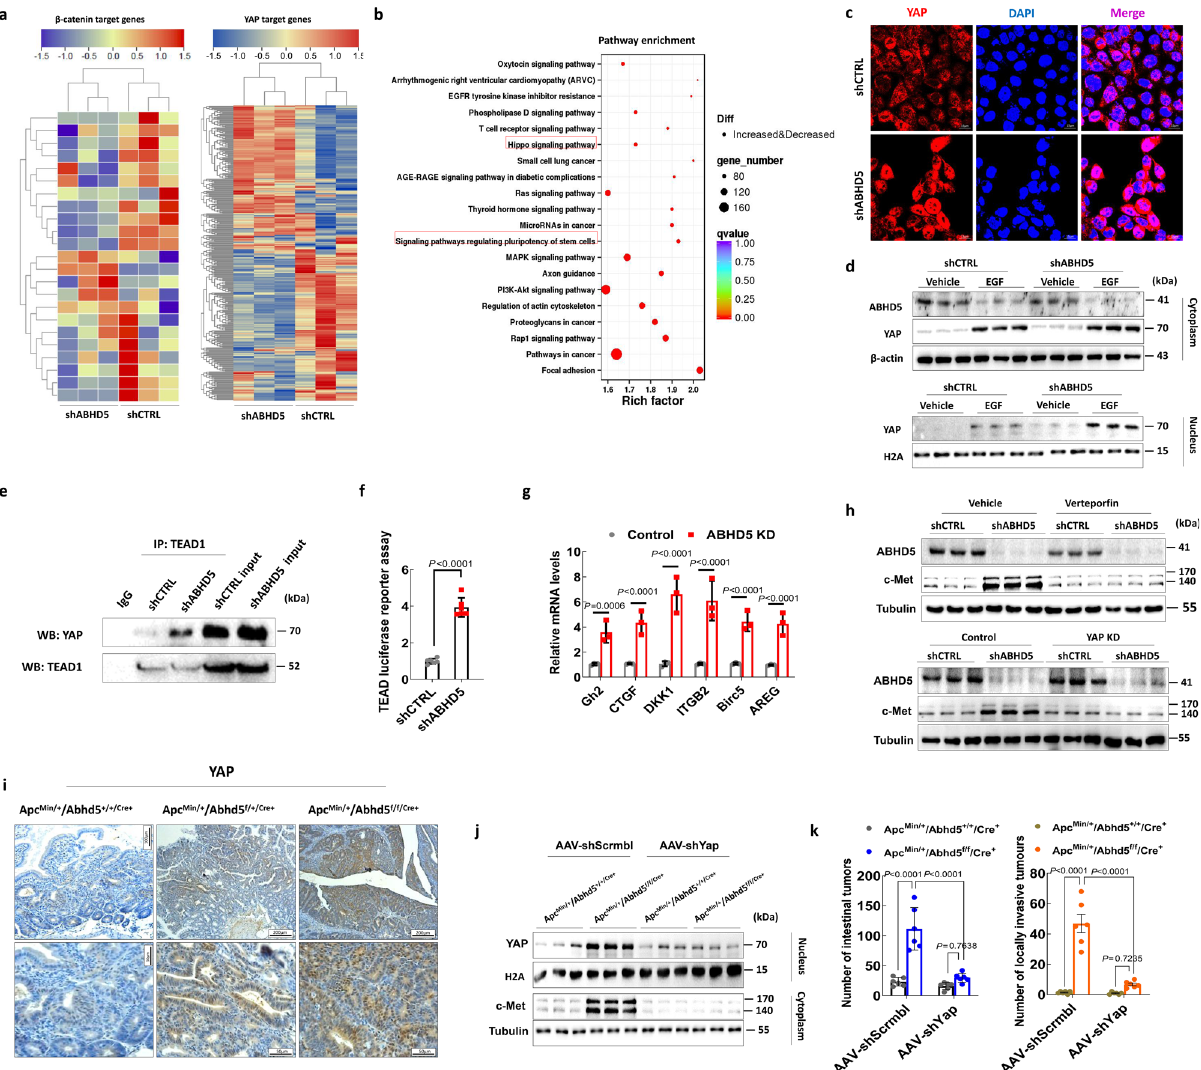
Fig. 4 Loss of ABHD5 promotes c-Met transcription via promoting the nuclear localization and activation of YAP. a Heatmap showing the expression patterns of β -Catenin or YAP target genes in shCTRL or shABHD5 HCT116 cells screened by Microarray. b KEGG pathway enrichment analysis of differentially expressed genes between shCTRL or shABHD5 HCT116 cells screened by Microarray. The top 20 positively and negatively enriched pathways are shown in the bar plot. c Representative immuno fl uorescent staining of YAP in shCTRL or shABHD5 HCT116 cells. d Subcellular fractionation immunoblotting of cytosolic and nucleic YAP in shCTRL or shABHD5 HCT116 cells treated with either EGF (200 ng/ml) or vehicle (PBS). e TEAD immune complexes were immunoprecipitated from shCTRL or shABHD5 HCT116 cells and subjected to immunoblotting of YAP. f TEAD luciferase reporter assay in shCTRL or shABHD5 HCT116 cells ( n = 3 biologically independent samples). g Real-time PCR assay of the indicated target gene mRNA levels in shCTRL or shABHD5 HCT116 cells ( n = 3 biologically independent samples). h Immunoblotting of ABHD5 and c-Met expression levels in shCTRL or shABHD5 HCT116 cells treated with YAP knockdown or YAP inhibitor vertepor fi n (15 μ M), DMSO as a vehicle control. i Representative immunohistochemistry staining of YAP expression in paraf fi n sections of the intestinal tumours of 100-day-old male mice. Apc Min/ + /Abhd5 + / + /Cre + , Apc Min/ + /Abhd5 f/ + /Cre + and Apc Min/ + /Abhd5 f/f/Cre + . Scale bar, 200 μ m and 50 μ m. j Immunoblotting of YAP and c-Met expression levels in the intestinal tumours of Apc Min/ + / Abhd5 + / + /Cre + and Apc Min/ + /Abhd5 f/f/Cre + mice injected with AAV-Scrmbl or AAV-shYap via the tail vein. H2A as a loading control for nuclear protein, and tubulin as a loading control for cytoplasmic protein. k Statistical analysis of the number of total and locally invasive tumours in the entire small intestine of Apc Min/ + /Abhd5 + / + /Cre + and Apc Min/ + /Abhd5 f/f/Cre + mice injected with AAV-Scrmbl or AAV-shYap via the tail vein ( n = 6 mice/group) (Data are shown as mean ± s.e.m. Unpaired two-sided Student ’ s t test was used in panel ( f ), whereas panels ( g ) and ( k ) were analysed using two-way ANOVA and Sidak ’ s multiple comparison test. Source data are provided as a Source Data fi